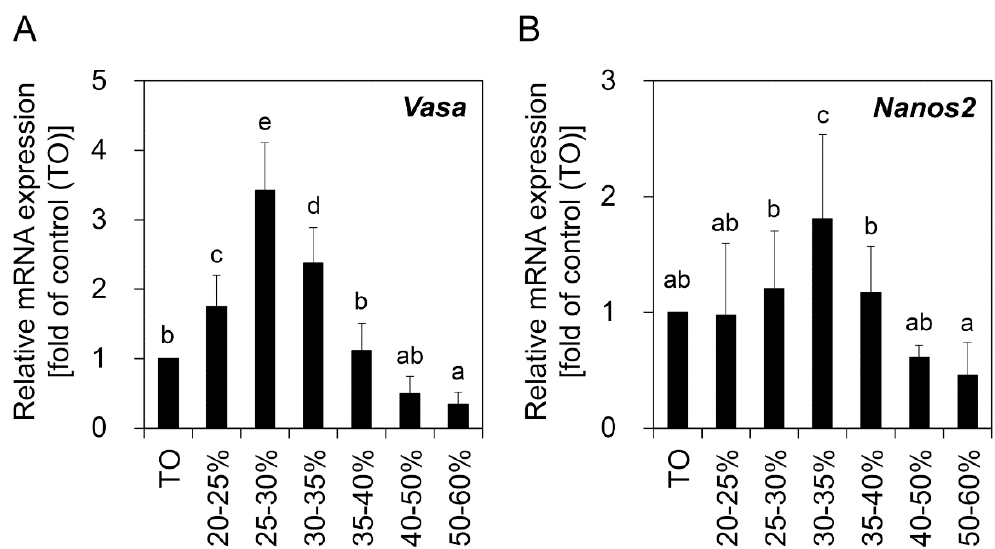
Figure 2. Relative expression of Vasa and Nanos2 genes in the ovary-derived cell populations separated by PDGC. Crude TO was harvested by enzymatic dissociation of the ovaries derived from 10 adult females. Following PDGC, cells from each density fraction were subjected to qRT-PCR analysis for comparison of Vasa ( A ) and Nanos2 ( B ) expression levels. TO was used as a control. Significant increases in Vasa expression were observed in the cells from the 20–35% density fractions. For Nanos2 , the highest expression level was observed in cells from the 30–35% density fraction. The values are expressed as mean ±SD. a-e Different letters indicate significant differences; p < 0.05.